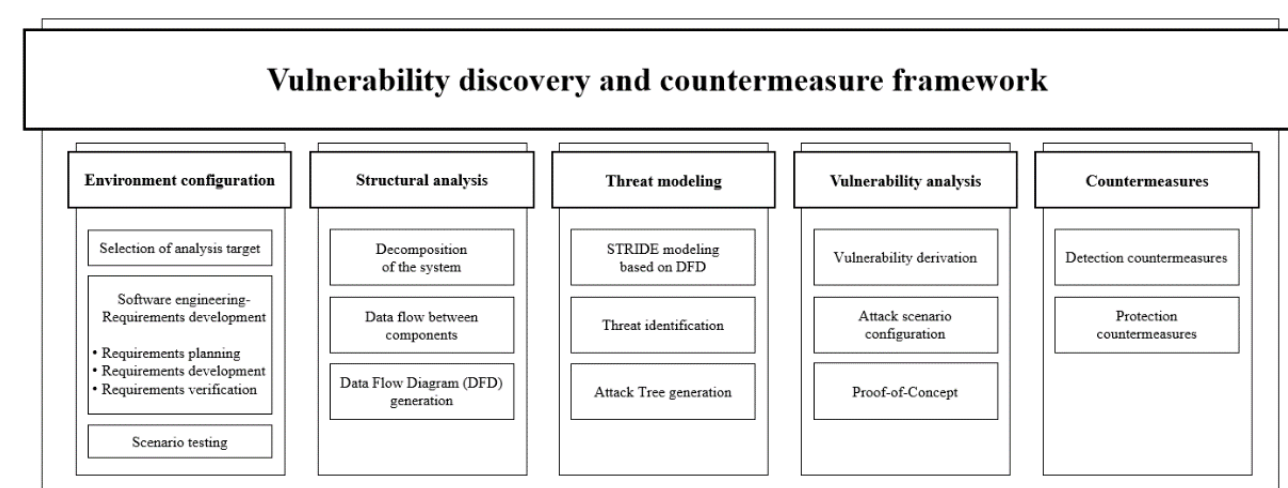
Figure 5. Proposed vulnerability discovery and countermeasure framework.